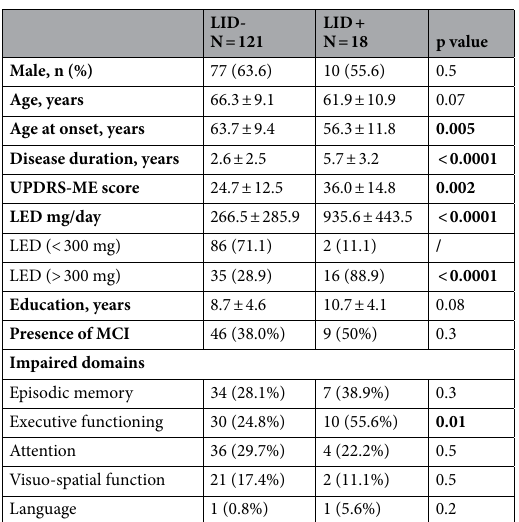
Table 1. Demographic and clinical characteristics at baseline. LID: levodopa induced dyskinesia; UPDRS-ME: Unified Parkinson’s Disease Rating Scale-Motor Examination; LED: levodopa equivalent dosage; MCI: mild cognitive impairment.